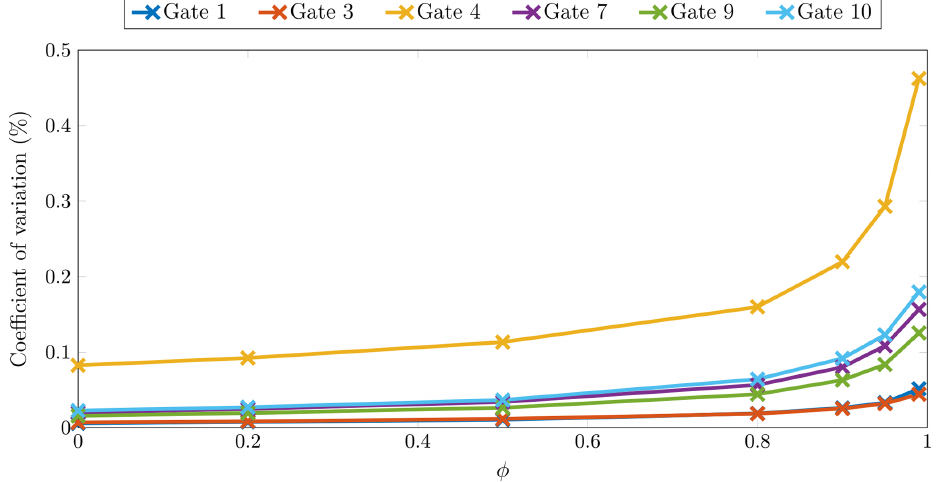
Figure 17. Coefficient of variation at the end of the simulation as a function of the temporal correlation φ . Results are for different